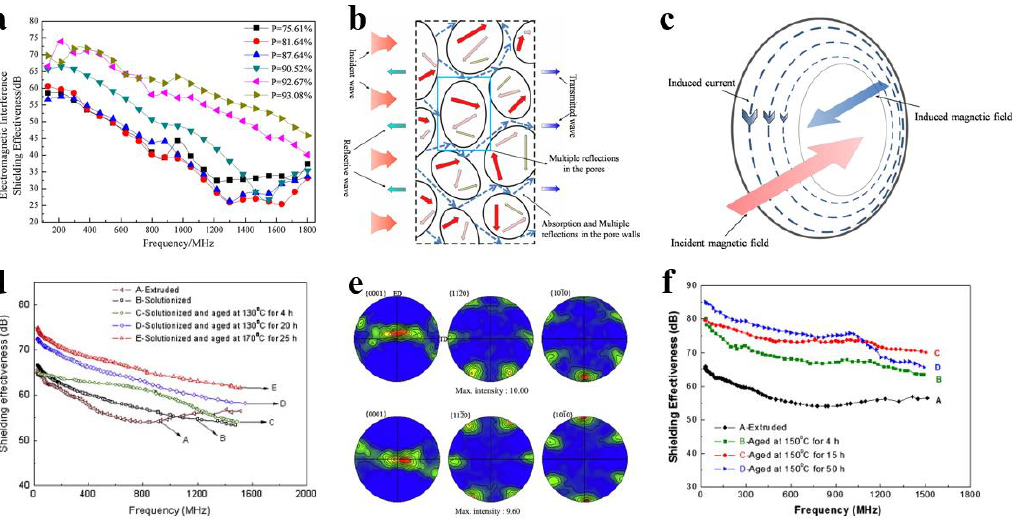
Figure 6. ( a ) Shielding effect of aluminum foam membrane [98]. Copyright 2014, Elsevier. ( b )